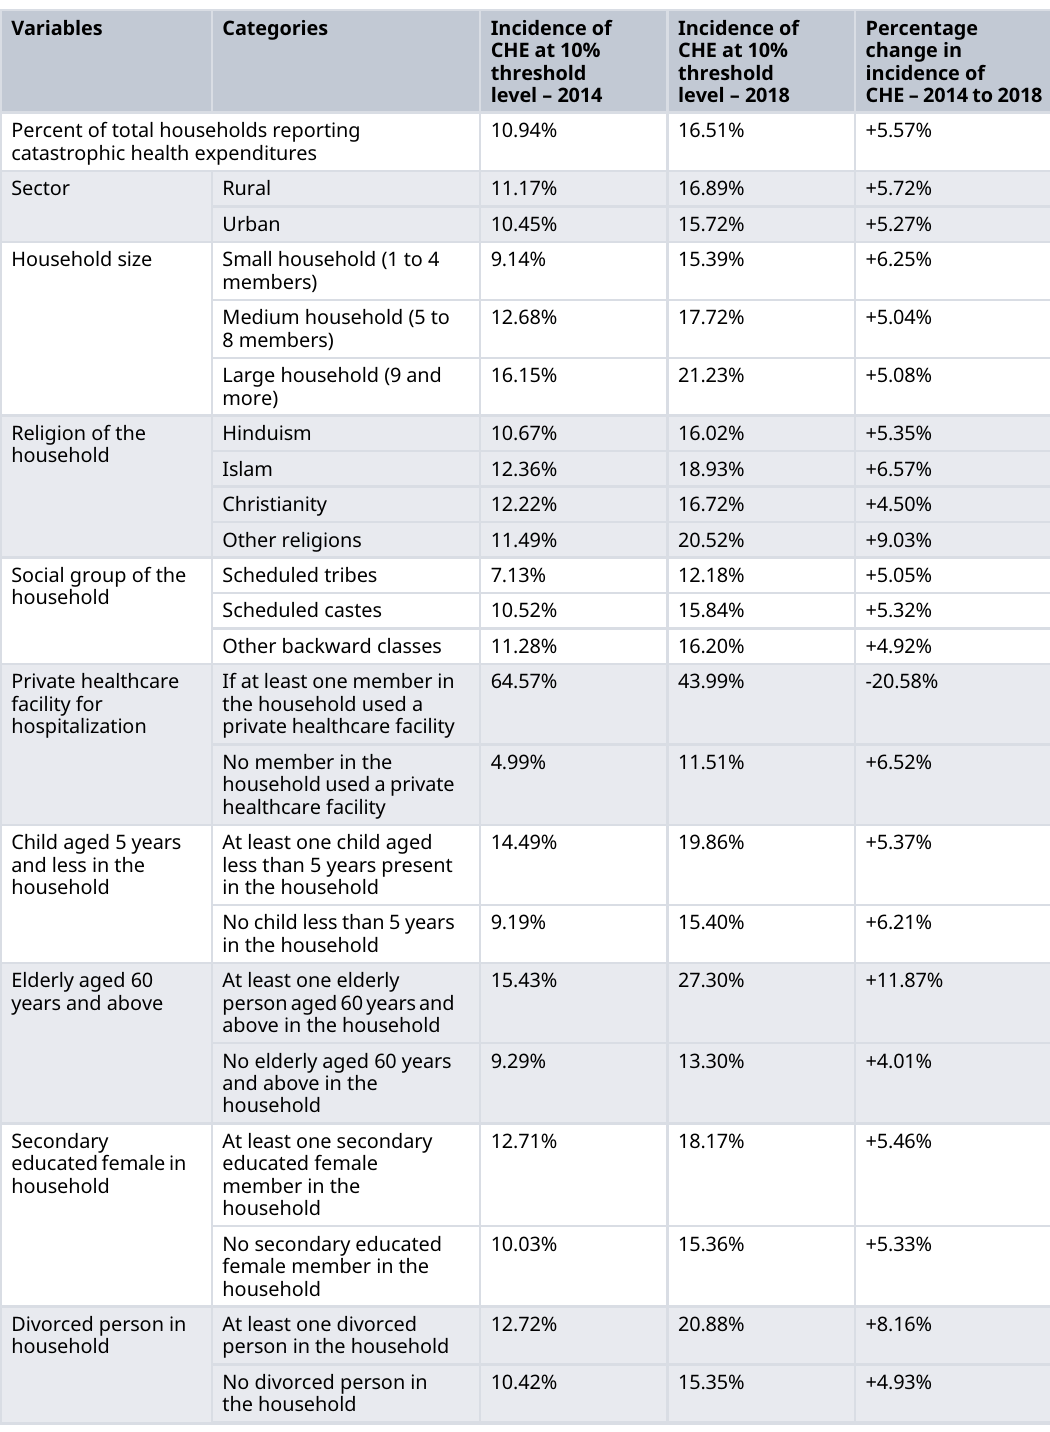
Table 2. Incidence of CHE by household